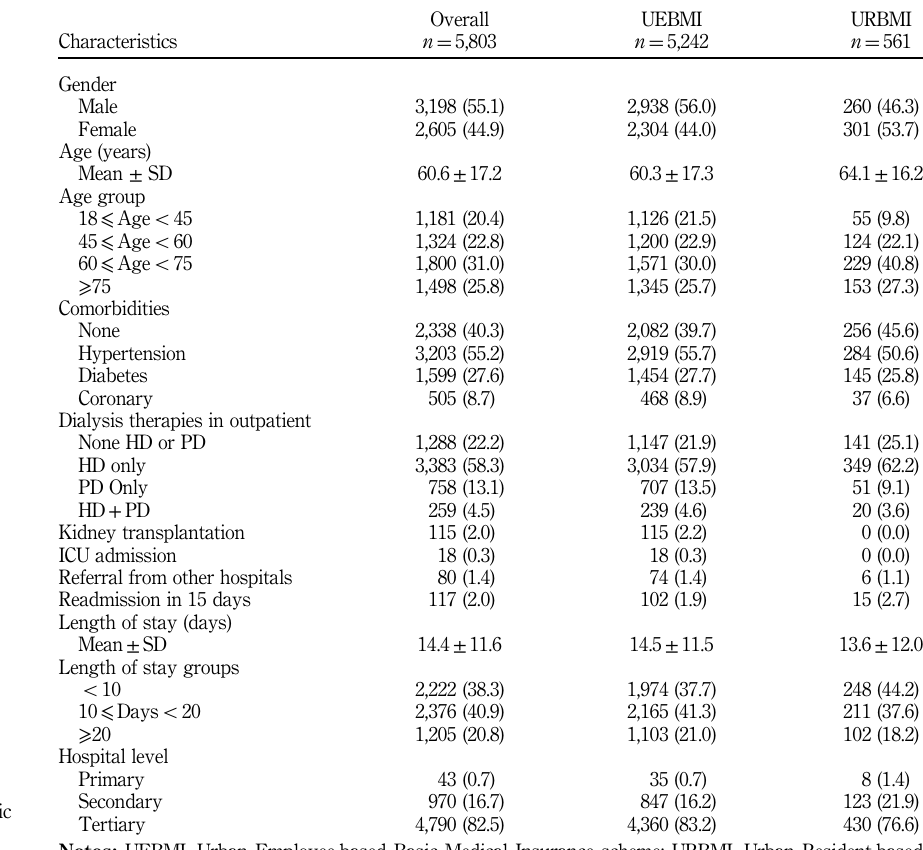
Table II. Socio-demographic characteristics of inpatients by insurance types, n